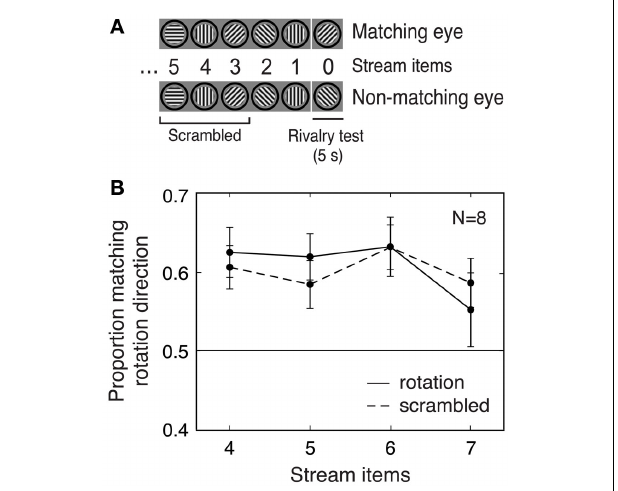
FIGURE 2 | Experiment 2: Effects of predictive context depend only on recent stimulus history. (A) Schematic of the stimuli. For the scrambled condition, the order of the gratings in the first part of the rotation stream (preceding the final two items) was randomized so that the first part of the stream did not contain a consistent rotation. However, the two stream items immediately before the rivalry test were always consistent with a particular rotation direction (in this example, clockwise) for both rotation and scrambled trials. (B) Scrambling the sequence of orientations in the stream prior to the final two stream items did not diminish the rotation matching effect. Error bars are SEM.